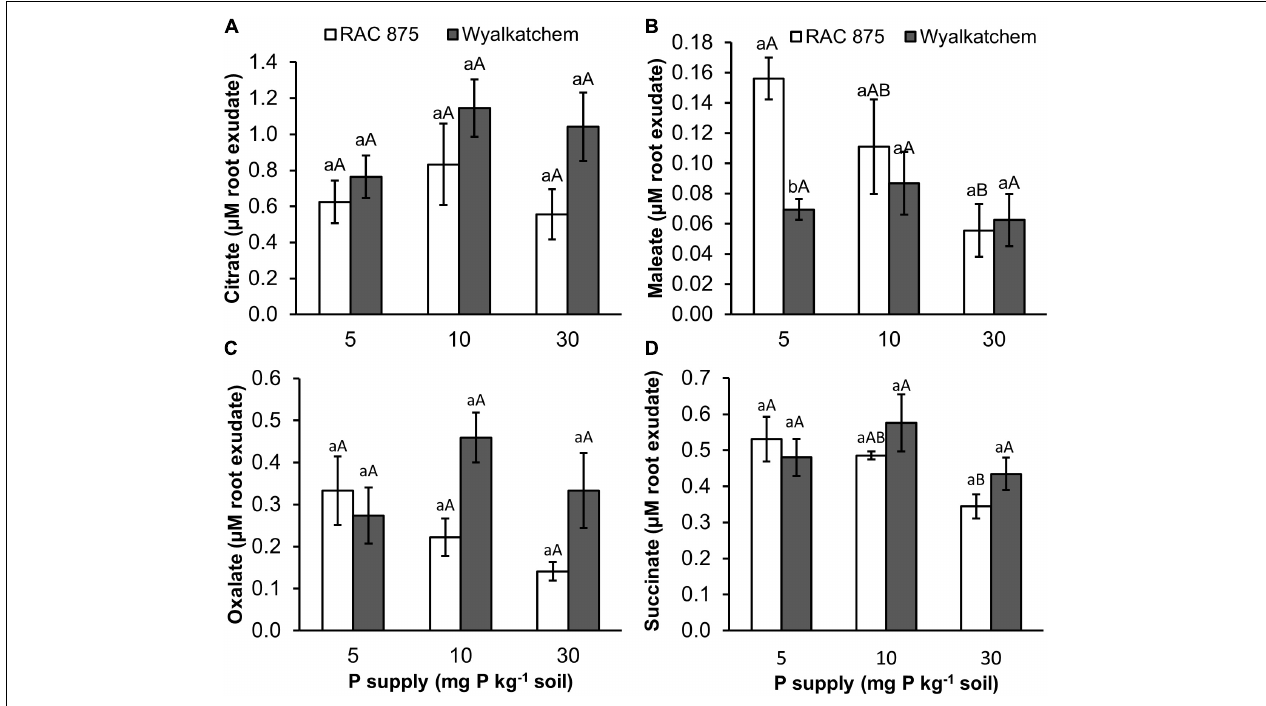
FIGURE 5 | Organic acid ( A = citrate, B = maleate, C = oxalate, and D = succinate) secretion in root exudate of two wheat genotypes RAC 875 and Wyalkatchem grown under different P treatments. Data represents the mean and standard error of five biological replicates. Different small letters (a,b) show significantly different between genotypes within the same P supply ( P < 0.05); different capital letters (A,B) show significantly different between P supply in each genotype ( P < 0.05).